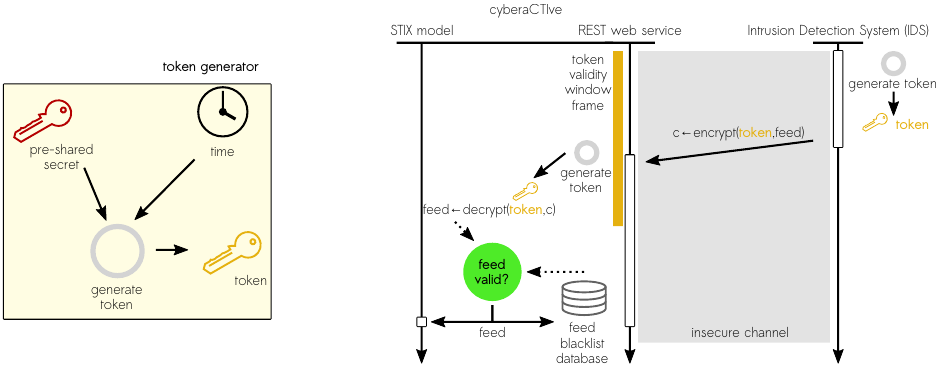
Figure 7. Architecture of the real-time feeder that extends cyberaCTIve